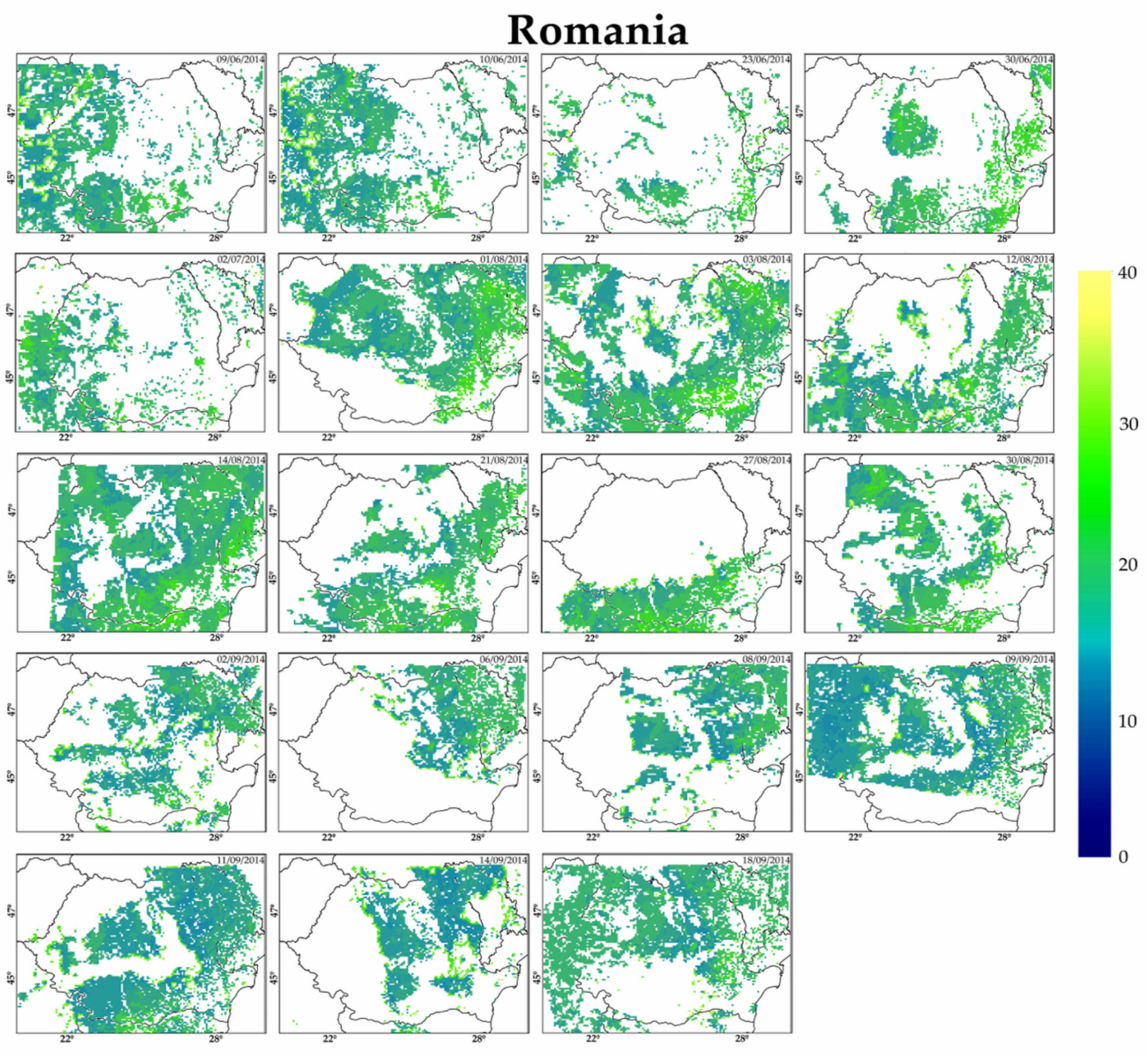
Figure 7. SEVIRI AOD uncertainty (UNC in %) specific for the Romanian